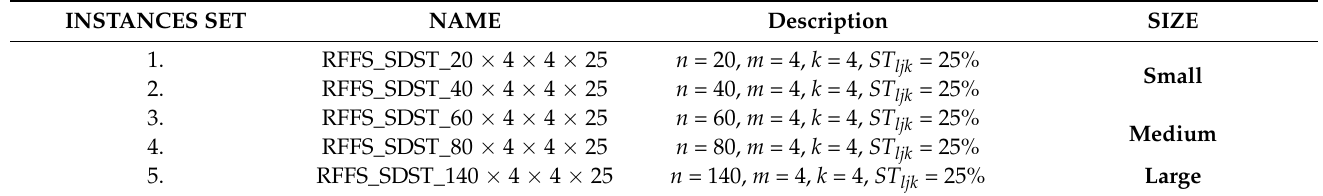
Table 2. Instances for tuning the